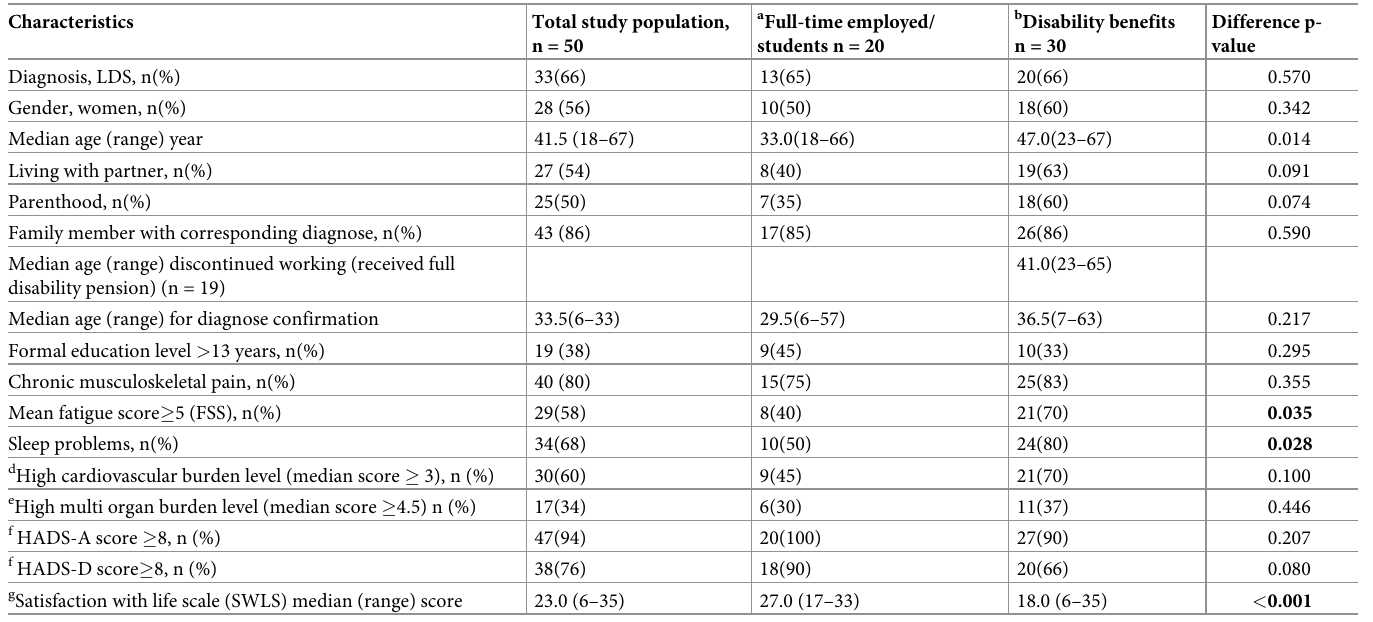
Table 1. Demographic and clinical factors in 50 adults with Loeys-Dietz- syndrome or vascular Ehlers-Danlos syndrome, according to employment status.